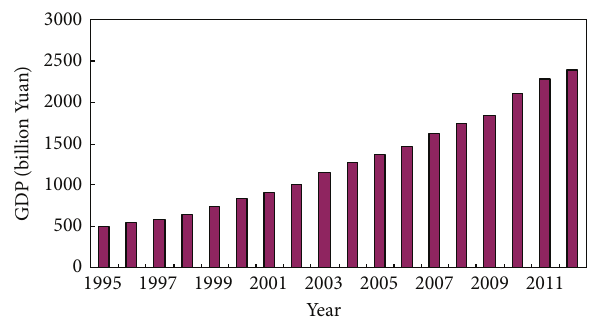
Figure 1: GDP and growth rate of Shandong province from 1995 to 2012. Source: Shandong Statistics Yearbook 2013.